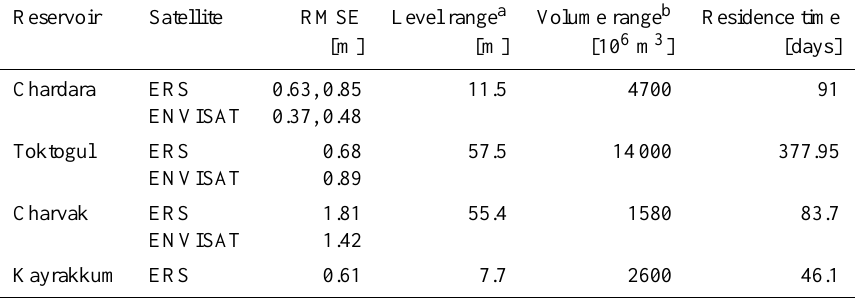
Table 4. Altimetry targets over each reservoir. The altimetry error is reported here as the RMSE of the altimetry time series with respect to the historical in-situ level time series. Level range and volume range denote the typical seasonal water level and volume variations in the reservoirs (derived from historical records). Residence time is the mean residence time in the reservoir. Reservoir Satellite RMSE Level range a Volume range b Residence time